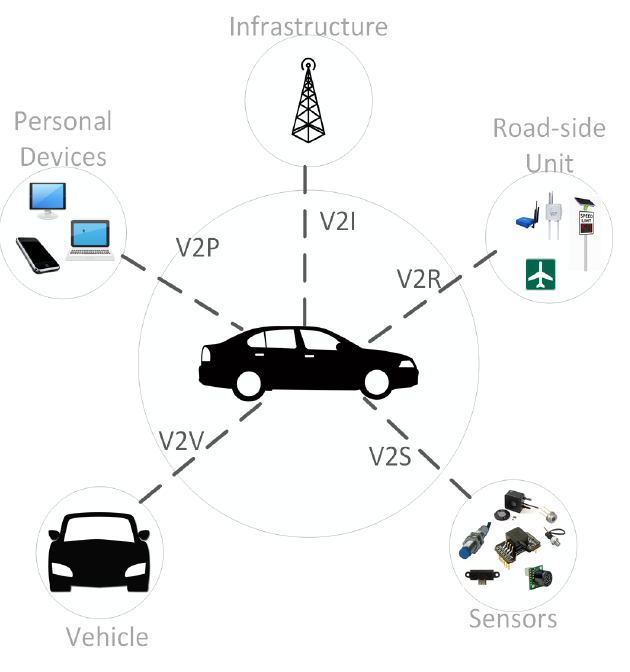
Fig. 4. Types of IoV communication, based on